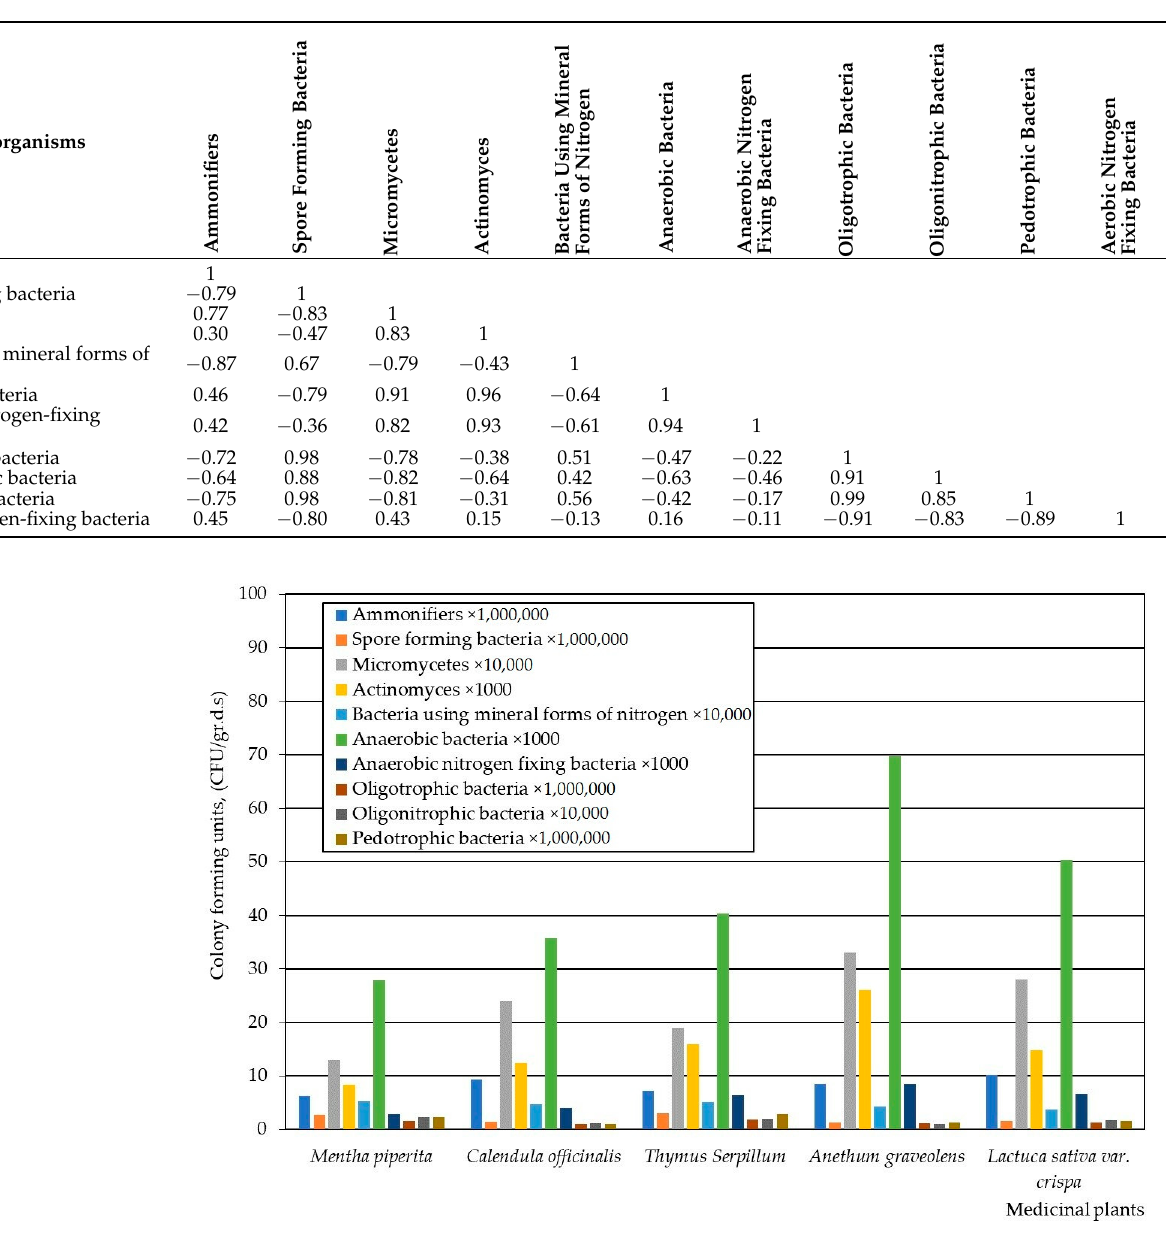
Figure 7. Microbial community composition (CFU/gr.d.s.) in soils of agroecosystems with medicinal plants without antibiotics. The data are statistically significant, p < 0.05, x ± SD, n = 4. There is also a high concentration of such microorganisms as spore-forming bacteria (3.02 × 10 6 CFU/gr.d.s.), bacteria that use nitrogen from mineral compounds (5.07 × 10 4 CFU/gr.d.s.), pedotrophs (2.88 × 10 6 CFU/gr.d.s.), oligotrophs (1.84 × 10 6 CFU/gr.d.s.), and oligoni- trophils (2.06 × 10 4